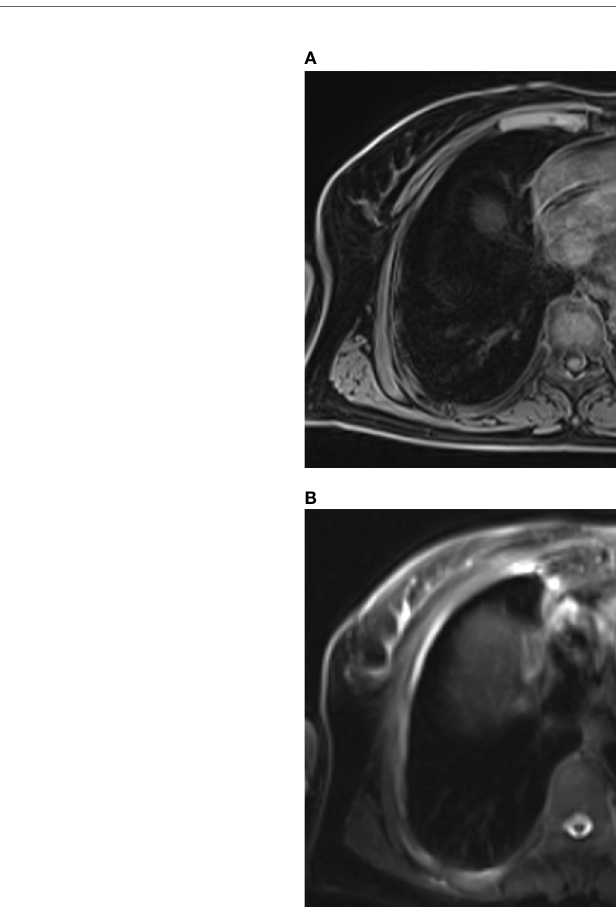
FIGURE 1 | MR-guided MWA for invasive adenocarcinoma of the left lower lobe for 72-year-old woman. Preoperative scan: Preoperative MRI showed a nodule in the left lower lobe, displayed as isointense signals on T1WI [ (A) arrow] and high signals on fsFRFSE T2WI [ (B)